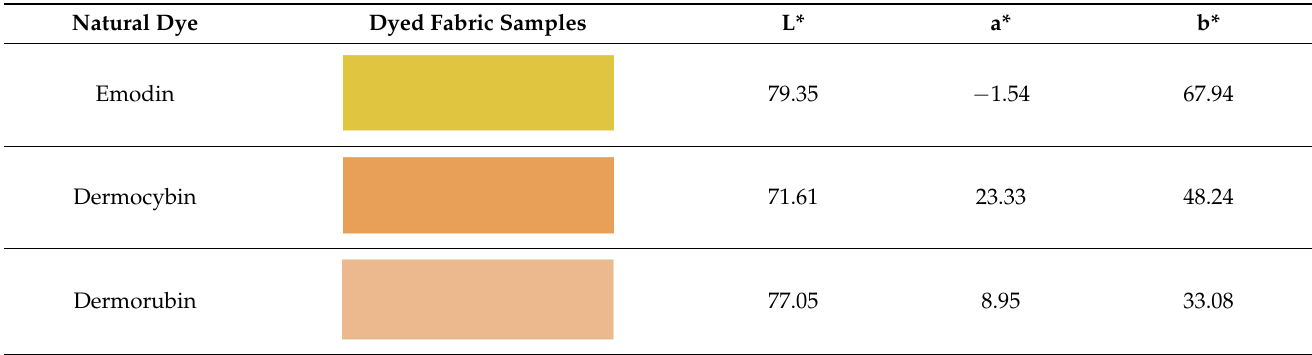
Table 1. CIE Lab color values obtained from polyester dyed with blood-red webcap dyes in Sc-CO 2 . Natural Dye Dyed Fabric Samples